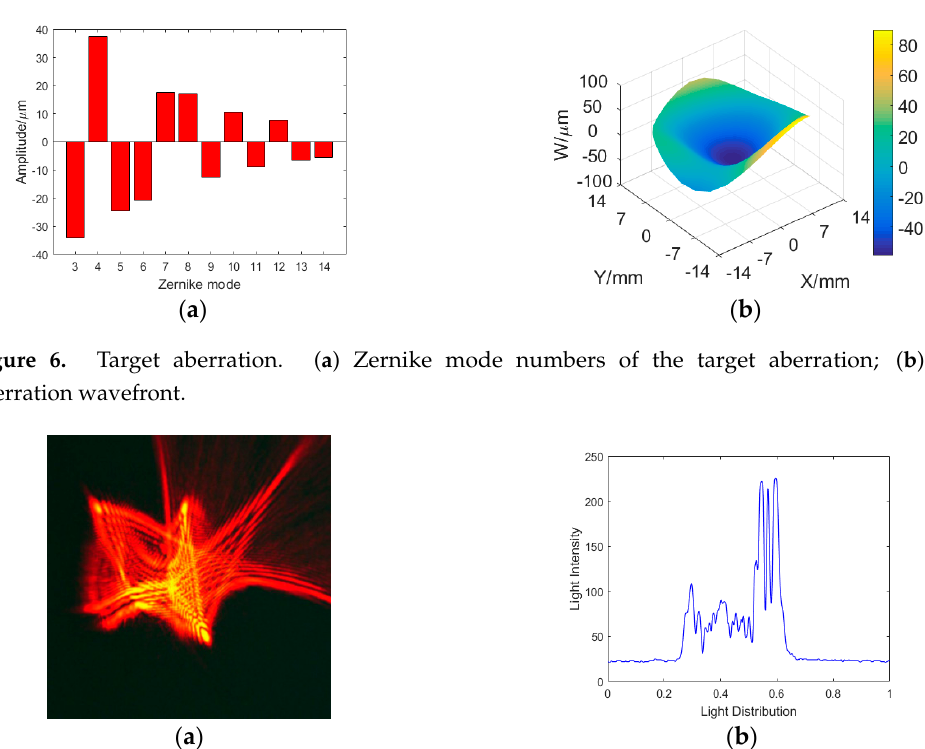
Figure 7. ( a ) The image captured by CCD with random aberration generated by the MFDM; ( b ) light intensity